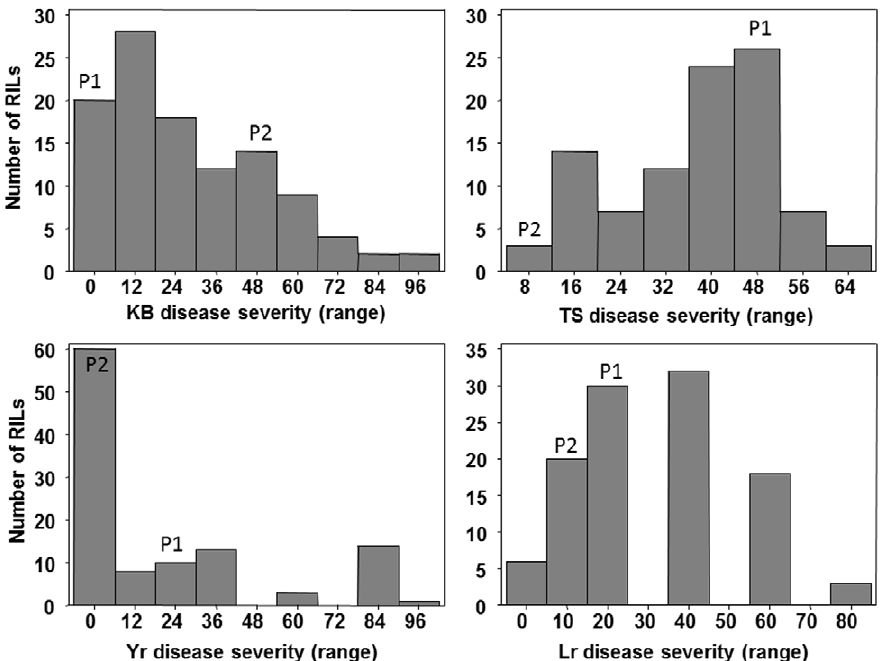
Figure 1. Disease frequency distribution of KB, TS, Yr, and Lr in the RIL population HD29/WH542. The mean value of the parents HD29 (P1) and WH542 (P2) is also shown on the figure.